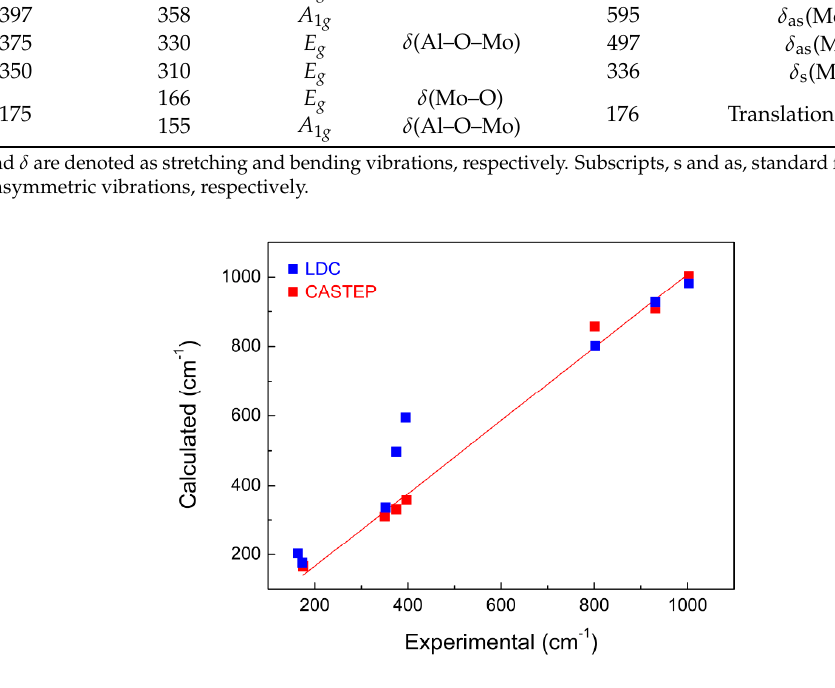
Figure 4. Experimental and calculated wavenumbers of KAl(MoO 4 ) 2 crystal by CASTEP (red squares) in this work and LDC (blue squares) carried out by Maczka et al. [8]